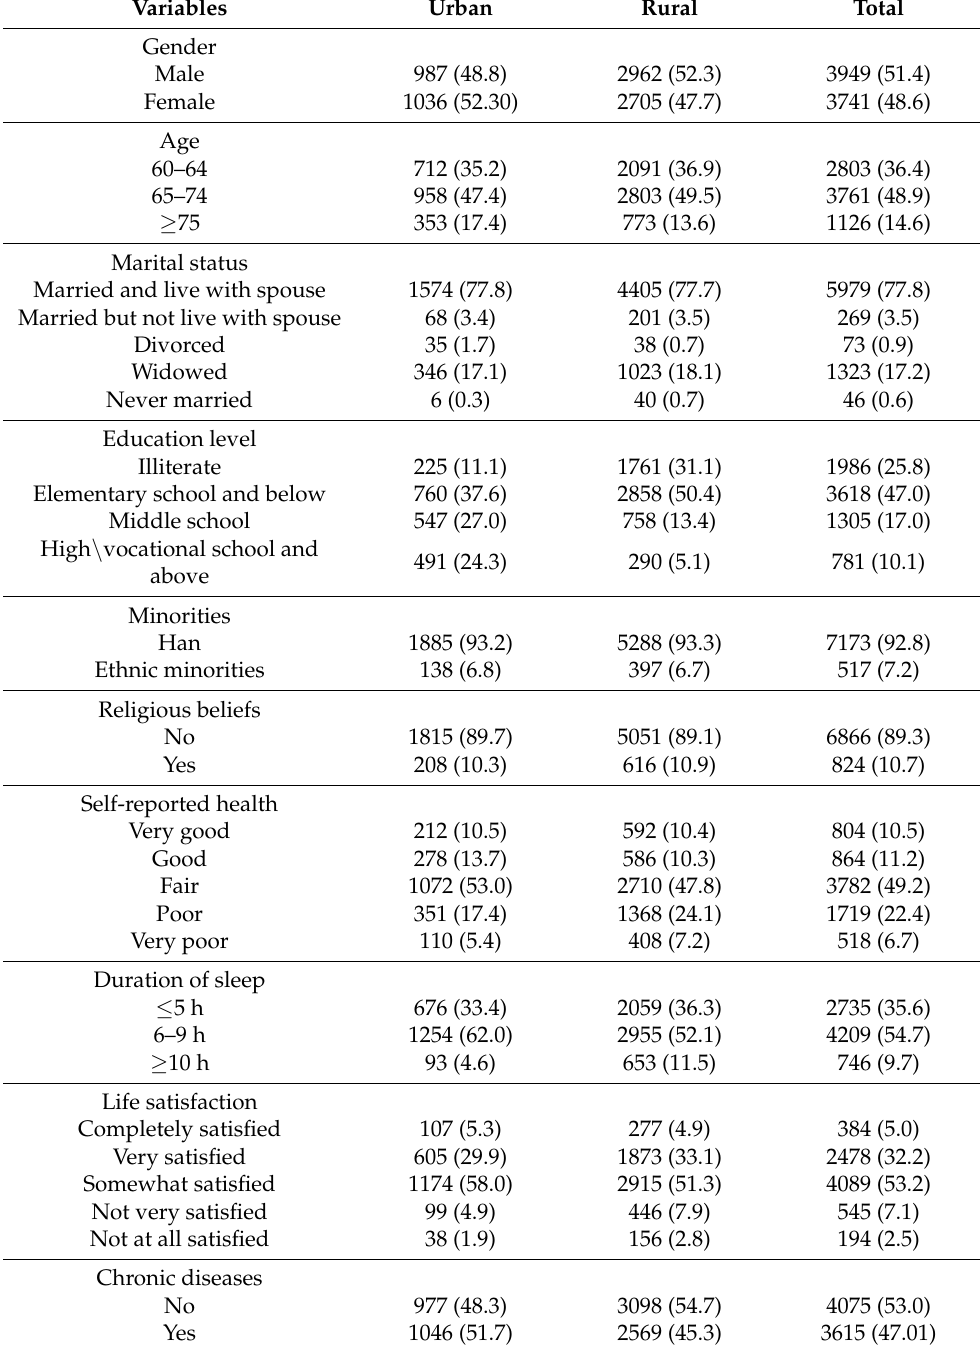
Table 2. Characteristics of participants (N